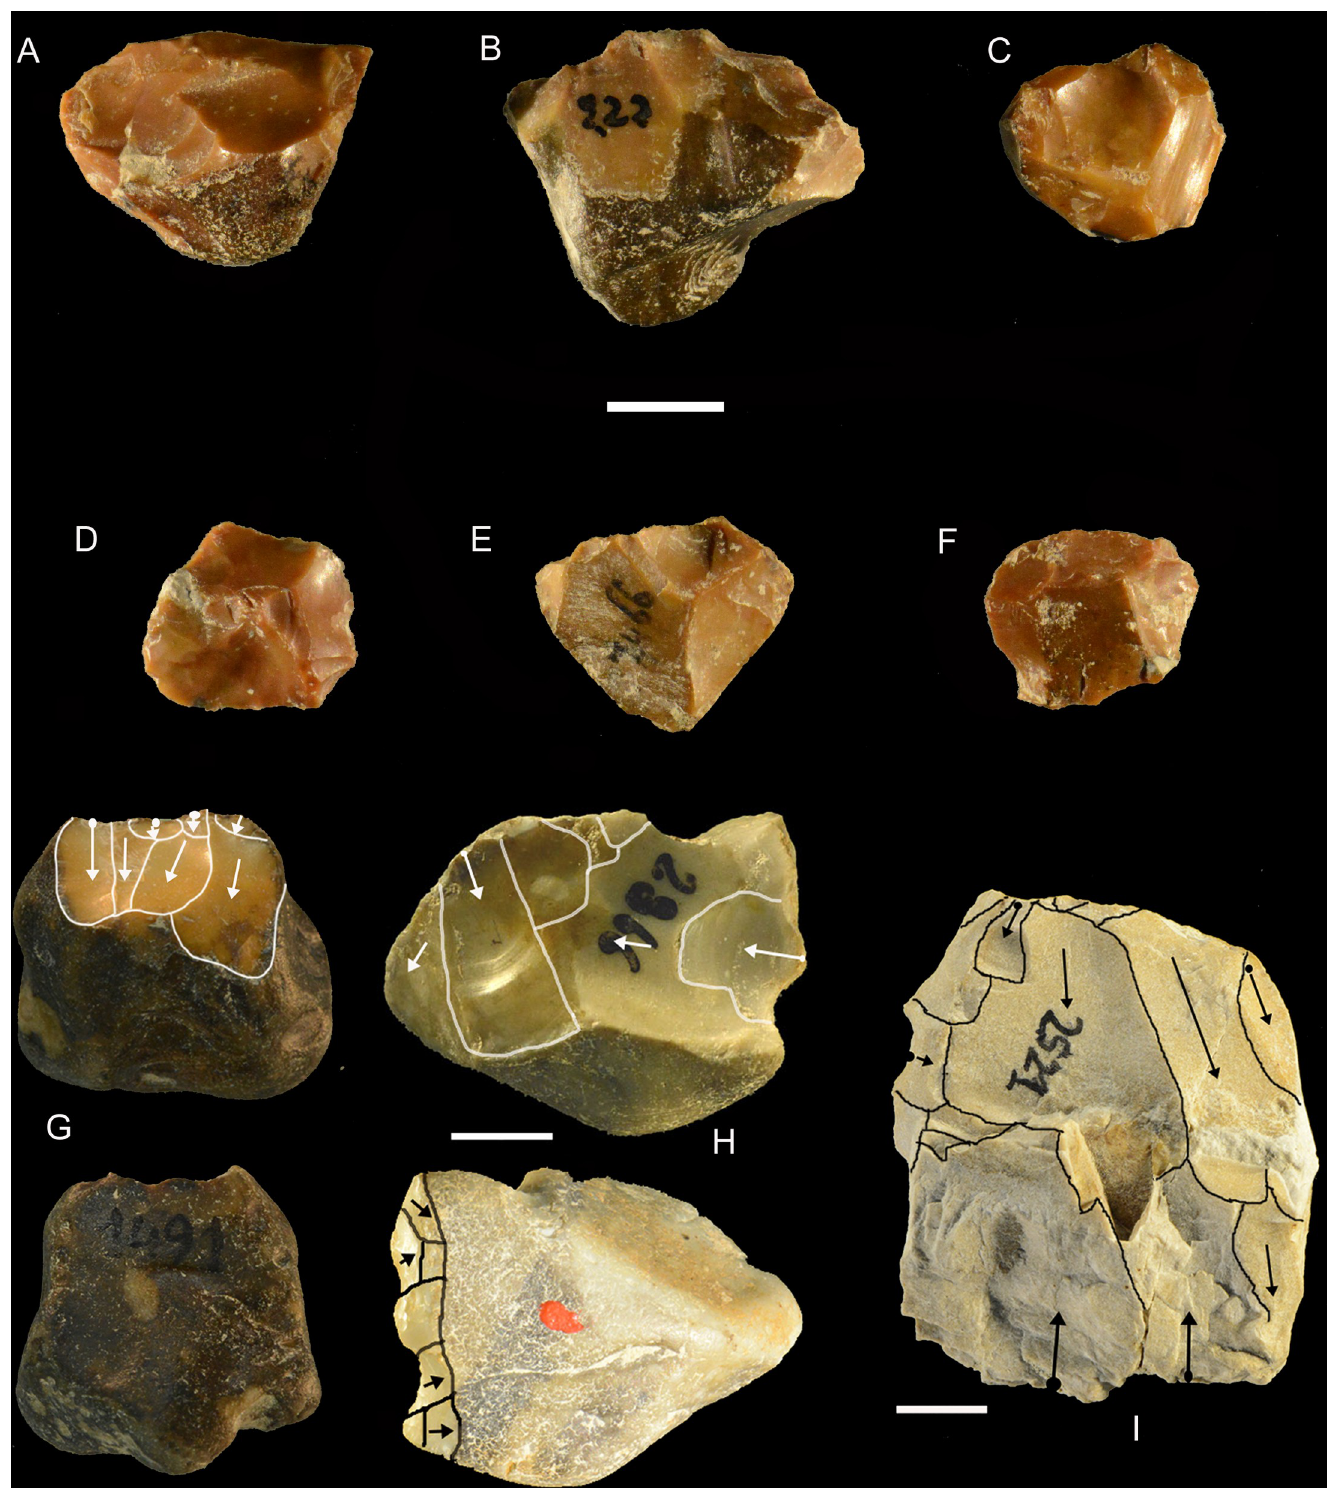
Fig 21. Castel di Guido lithics. Cores A-F are all of flint and all exhausted. Catalogue numbers 5158, 222, 3296,4394,7466,1991. G is of flint and is unidirectional. H has double patina indicating reuse. I is bidirectional but the lower removals are clearly failed due to the fissured and irregular texture of the raw material. Catalogue numbers of G-I are 1491, 2866, 2521. Scale bar 1